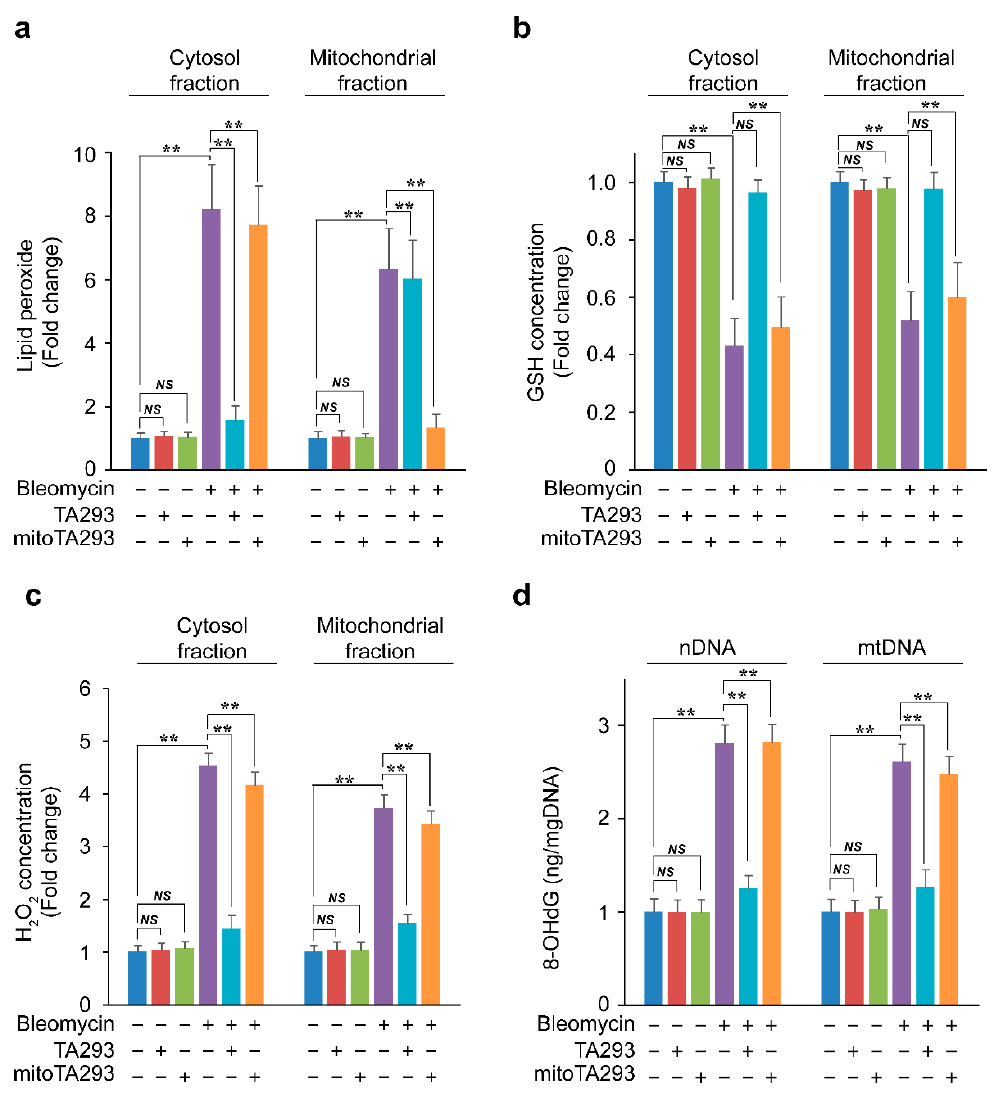
Figure 4. Effects of TA293 and mitoTA293 on the production of lipid peroxide, glutathione (GSH), H 2 O 2 , and oxidized DNA in cytosol and mitochondrial fractions in BLM-induced PAECs in vitro . Concentration of ( a ) lipid peroxide, ( b ) GSH, ( c ) H 2 O 2 , and ( d ) 8-OHdG in the cytosol and mitochondrial fractions in BLM-induced PAECs. PAECs were treated with saline or BLM and with vehicle, TA293, or mitoTA293 for 72 h. The data are presented as the mean ± SEM ( n = 5 per group); ** p < 0.01; NS , not significant.